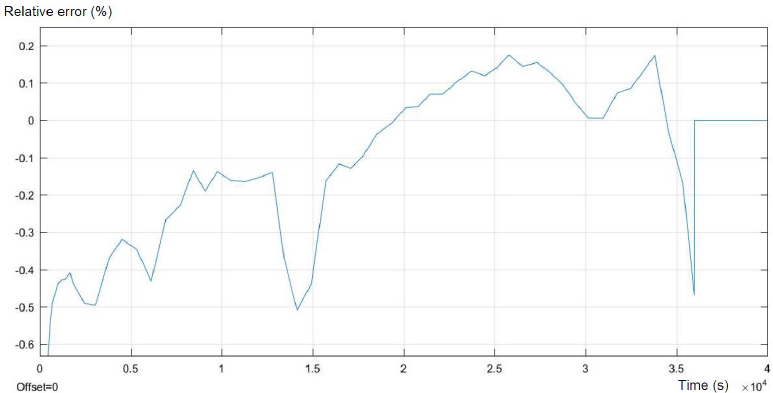
Figure 11. Relative error of the model.